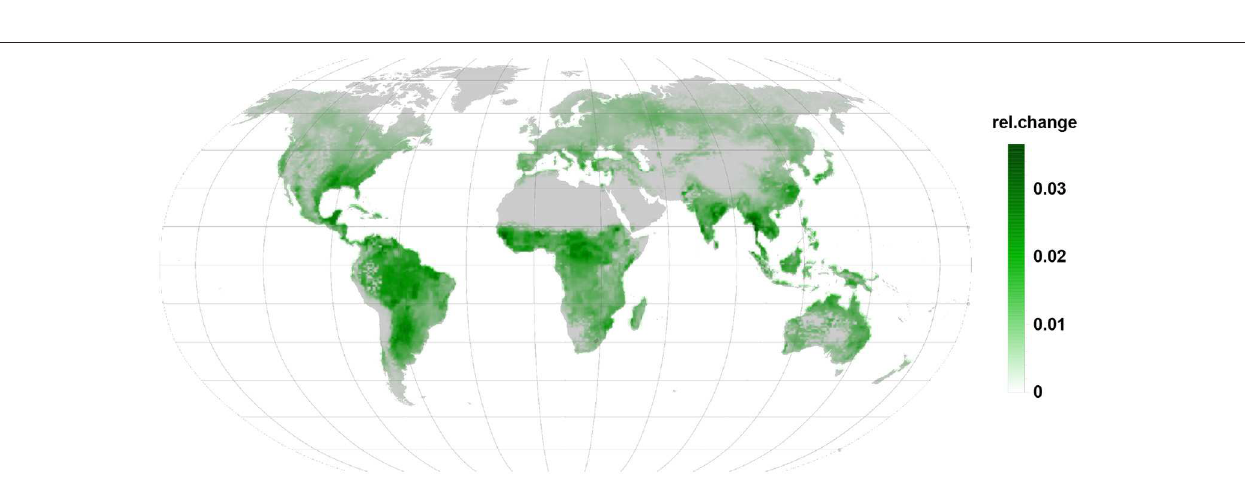
FIGURE 6 | Relative changes in LOX emission are as well positive and indicate increased emission. Being linked to the infected leaves they are apparent in all regions during the